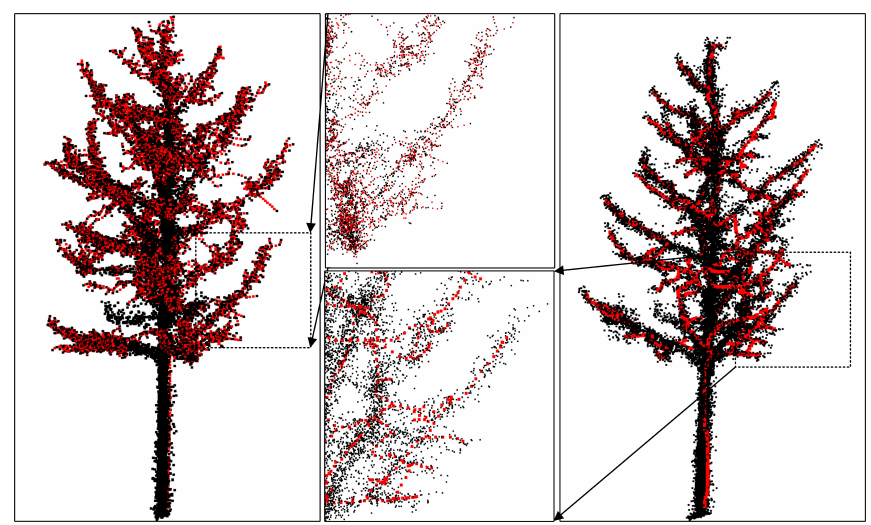
Figure 7. Comparison of the skeleton extraction with AD [17]. Table 1. Data information of skeleton